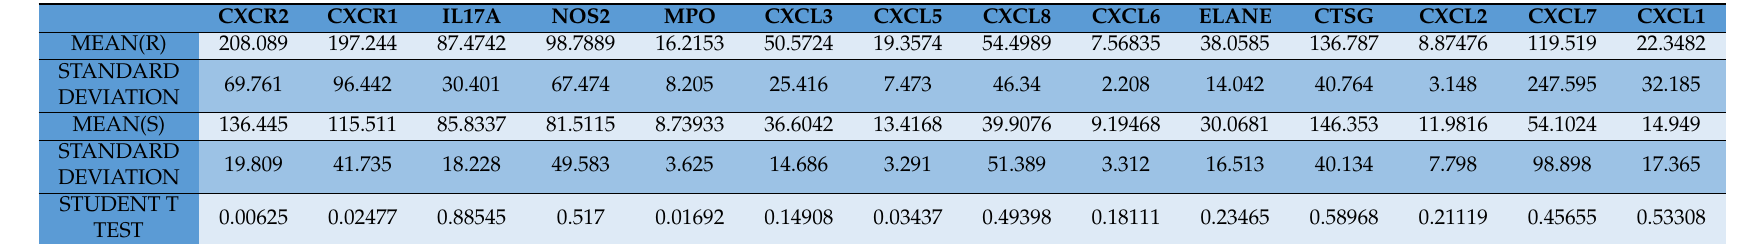
Table 1. Expression of neutrophil-related genes in human